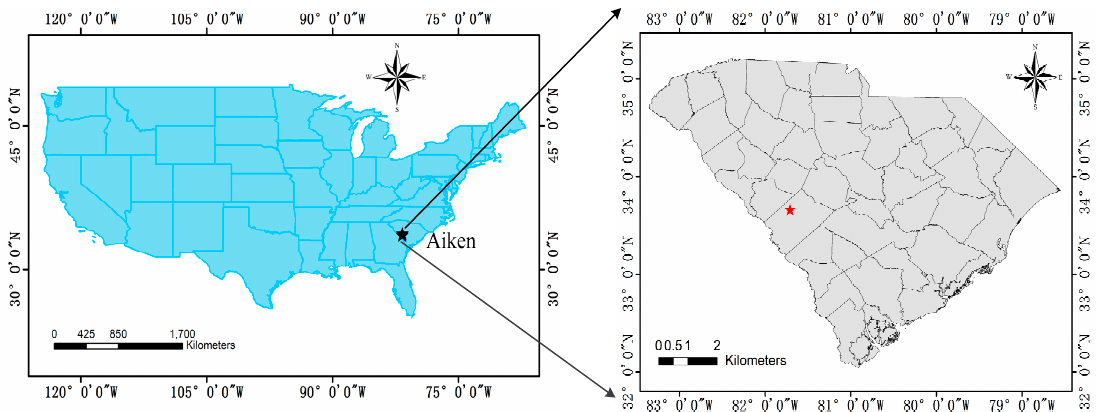
Figure 1 . Location of the study area at the national and state levels. Figure 1 shows a part of the study site using an image of a USA map. The left part of the image shows the location of the study area in the USA, the right part shows it relative to South